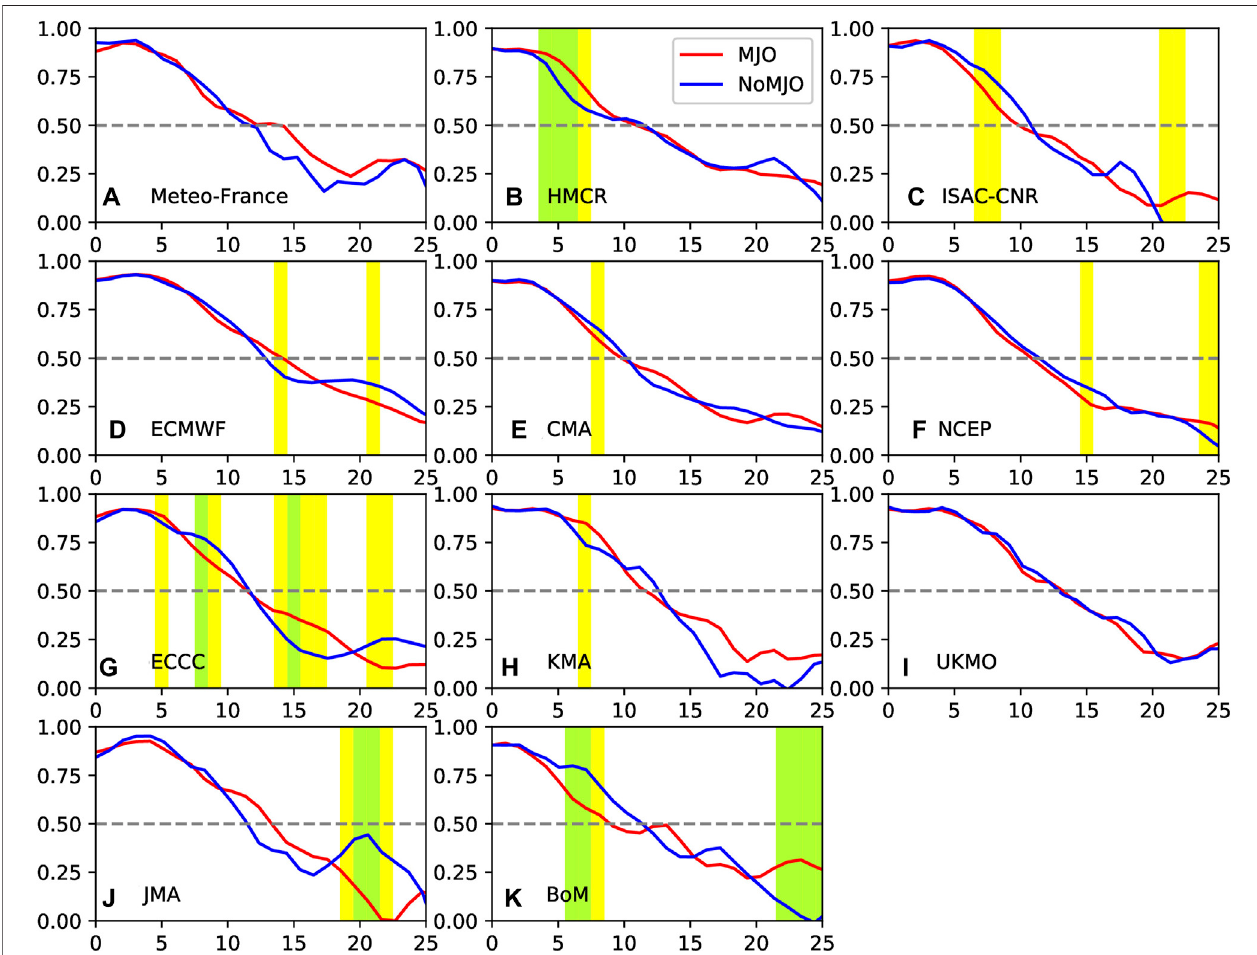
FIGURE5| Sameas Figure4 butfortheArcticOscillation(AO)predictioninitialedwiththenegativeAOphase,andthelegendisshowninpanel A .Panel (A-K) are for models of Meteo-France, HMCR, ISAC-CNR, ECMWF, CMA, NCEP, ECCC, KMA, UKMO, JMA, and BoM, respectively.